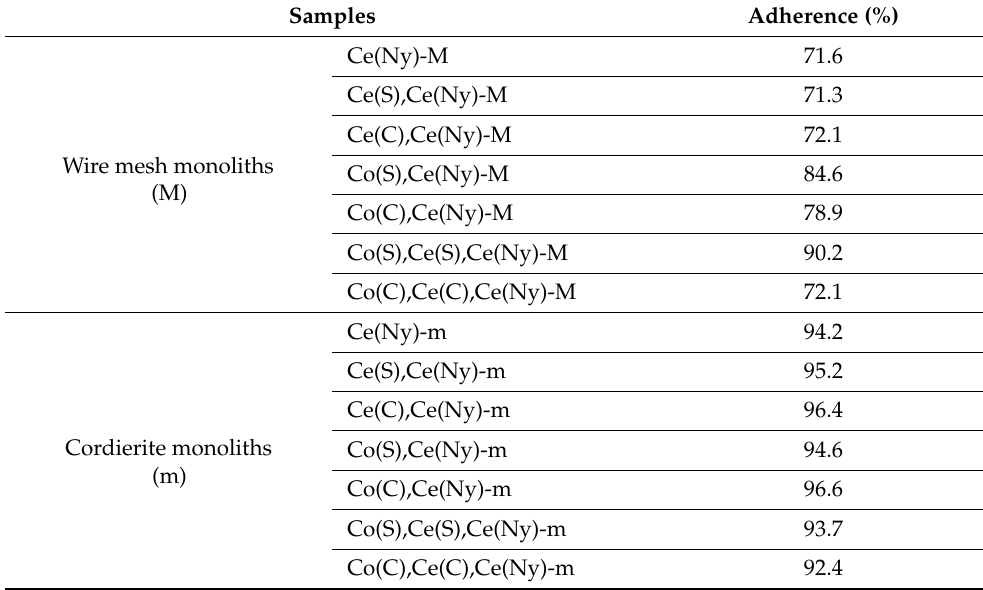
Table 2. Retention percentage (%) of the catalytic layer of the different catalytic systems after standard adherence